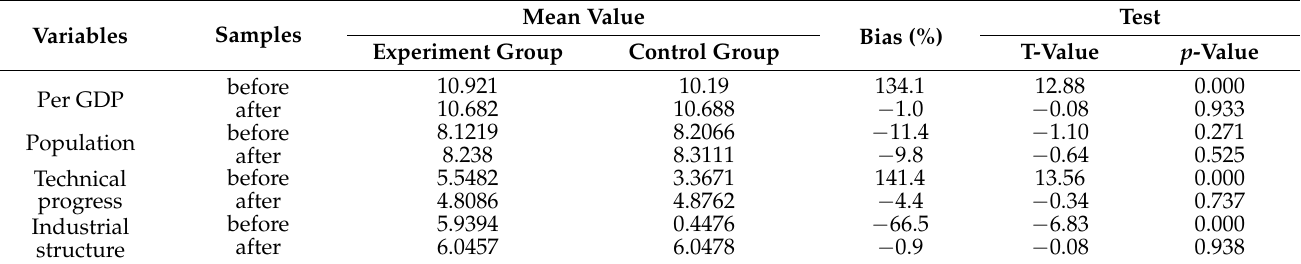
Table 3. Stationary test of variables before and after